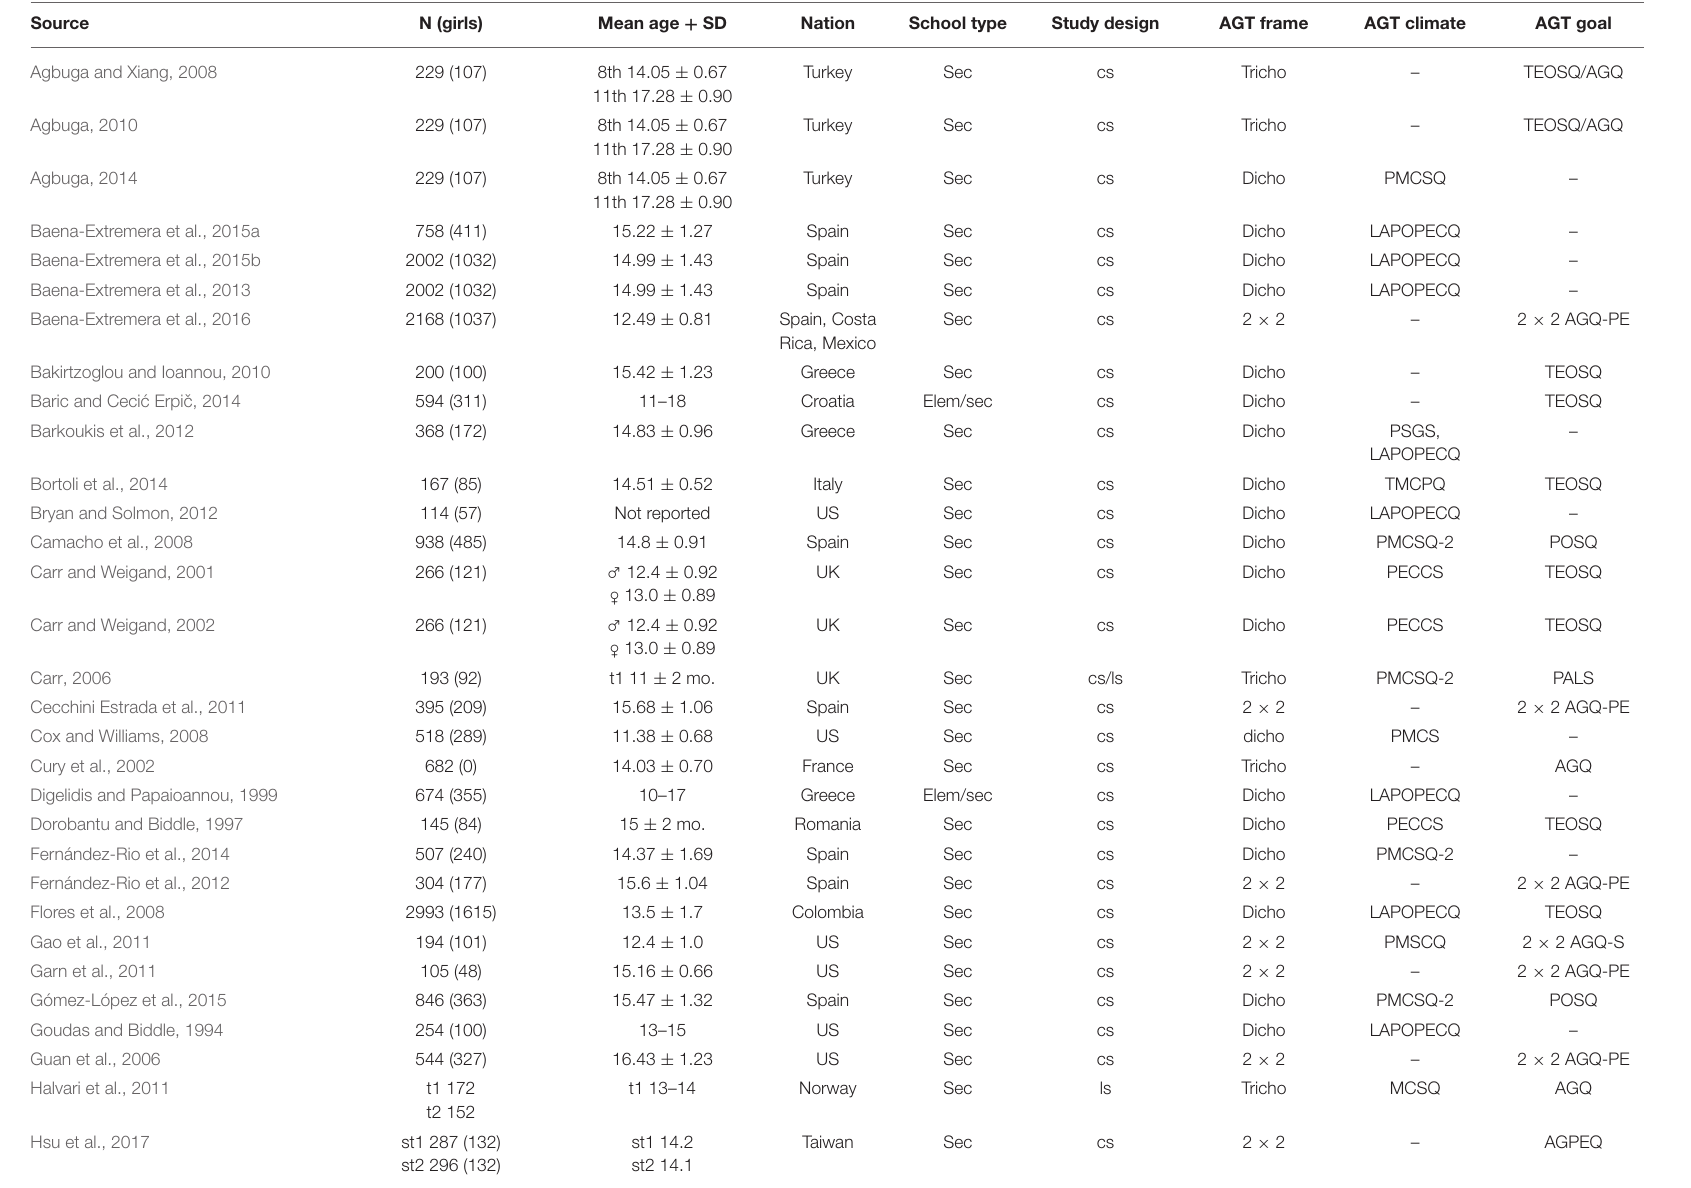
TABLE 1 | Descriptive characteristics of the included observational